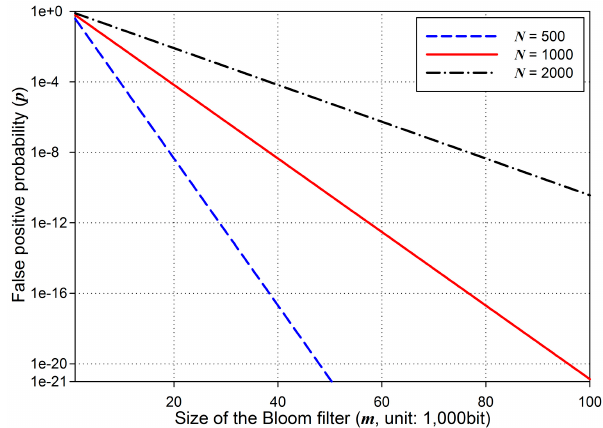
Figure 8. The probability of false positive in the Bloom filter.